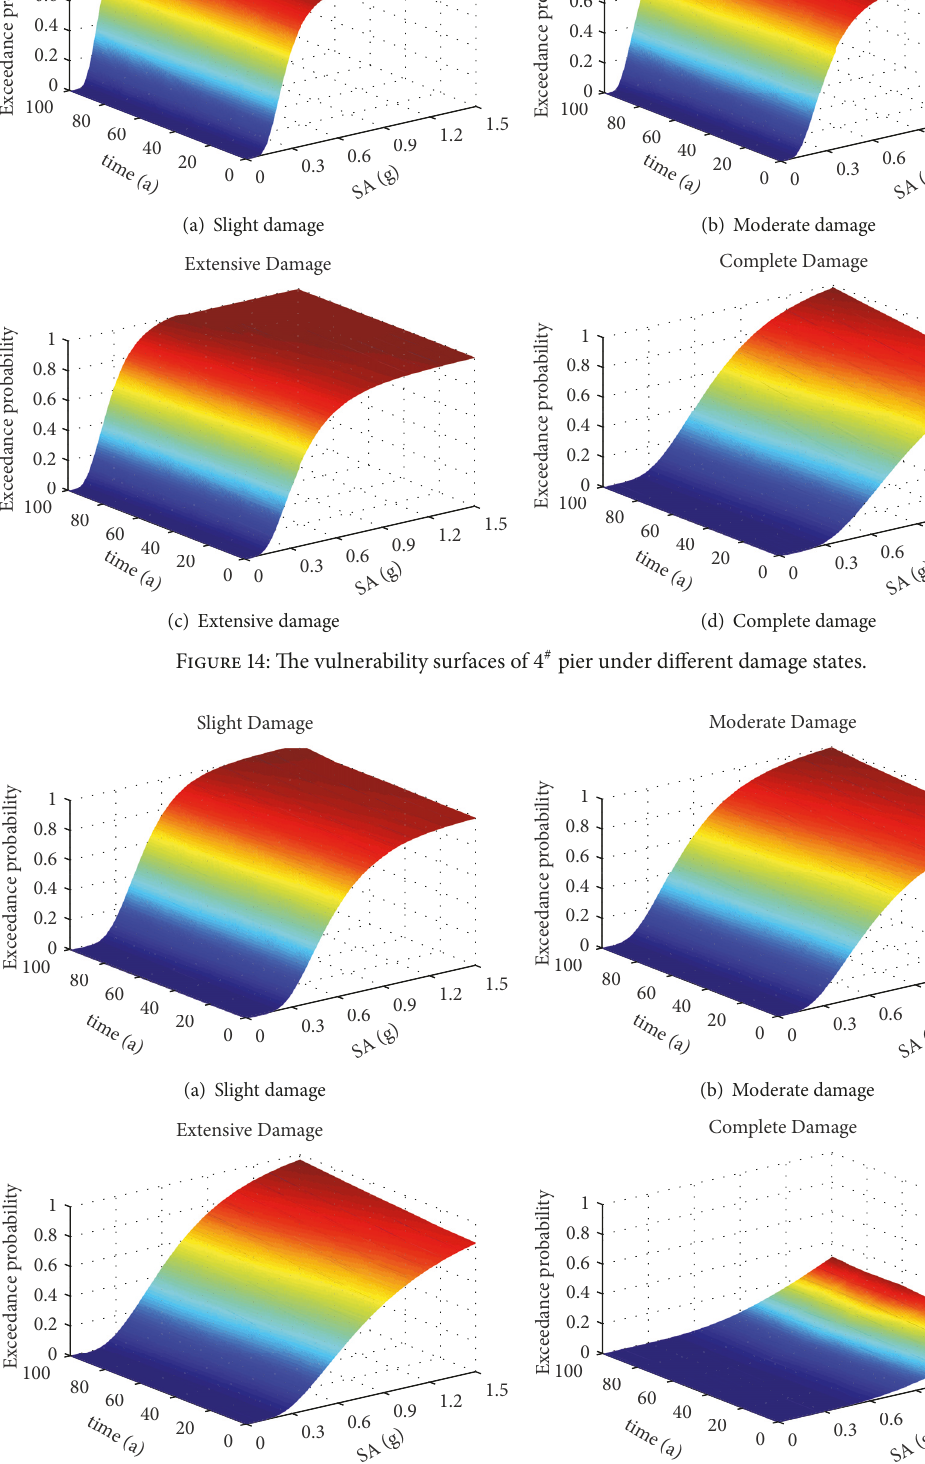
Figure 15: The vulnerability surfaces of 5 # pier under different damage